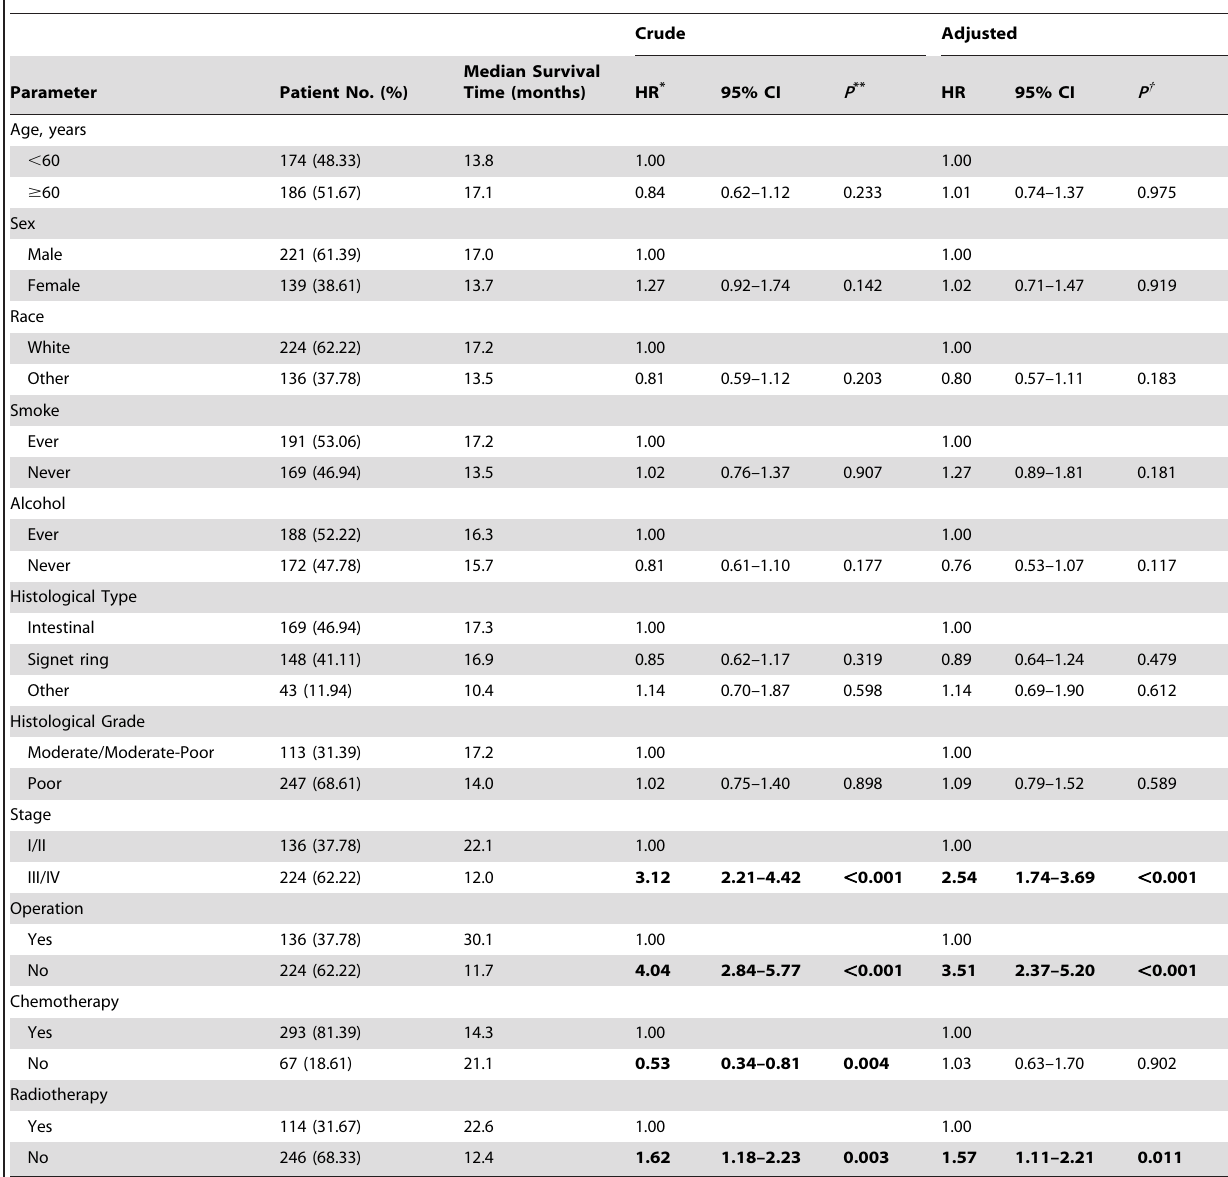
Table 1. Associations between characteristics of patients with gastric cancer and their overall survival.